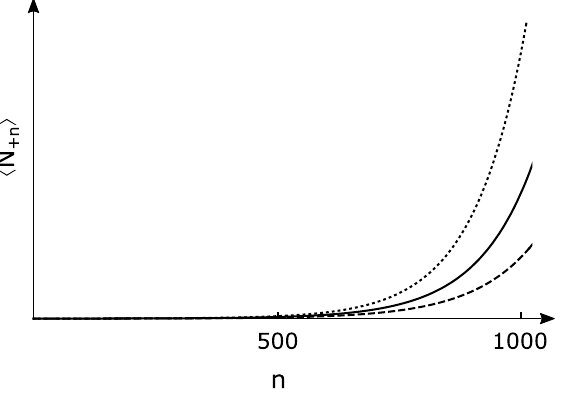
Figure 7. The number of outgoing particles as a function of the amplification steps at the fixed relative soliton 2.99 10 5 m/s (dotted line), u velocities u = × The circuit parameters are the same as in Fig. 6.